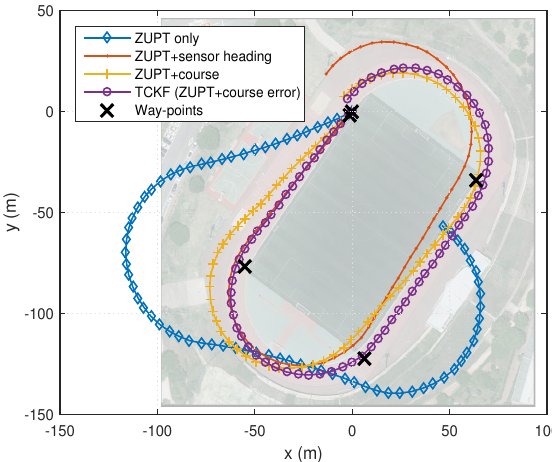
Figure 7. PDR results for the navigation systems on the left